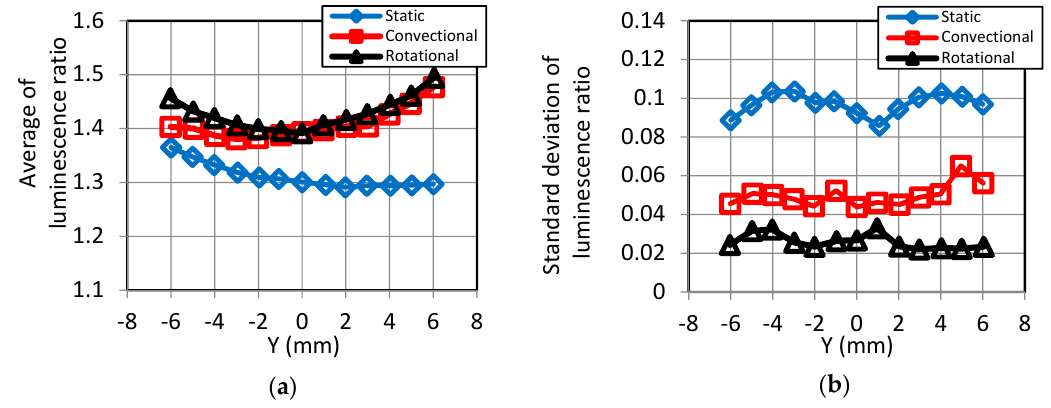
Figure 11. Statistical plots of luminescence ratios along the Y-axis. (a) Average; (b) Standard deviation